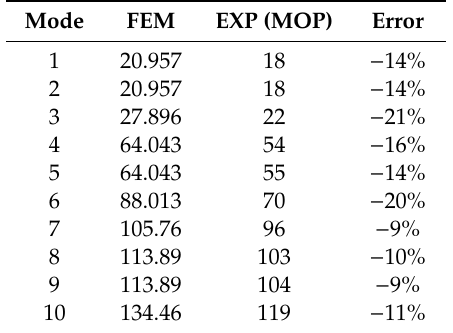
( c ) Figure 6. Three different OSP results along the x- and y-directions: The ( a ) multiobjective optimization problem (MOP); ( b ) forward sequential sensor placement (FSSP); and ( c ) random placement methods.